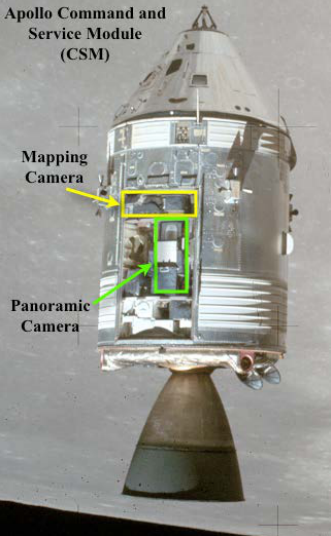
Figure 2: Apollo 15 Command and Service Module with Lunar Mapping Camera System and Panoramic Camera in the Scientific Instrument Module (from NASA image AS15-88-11972).